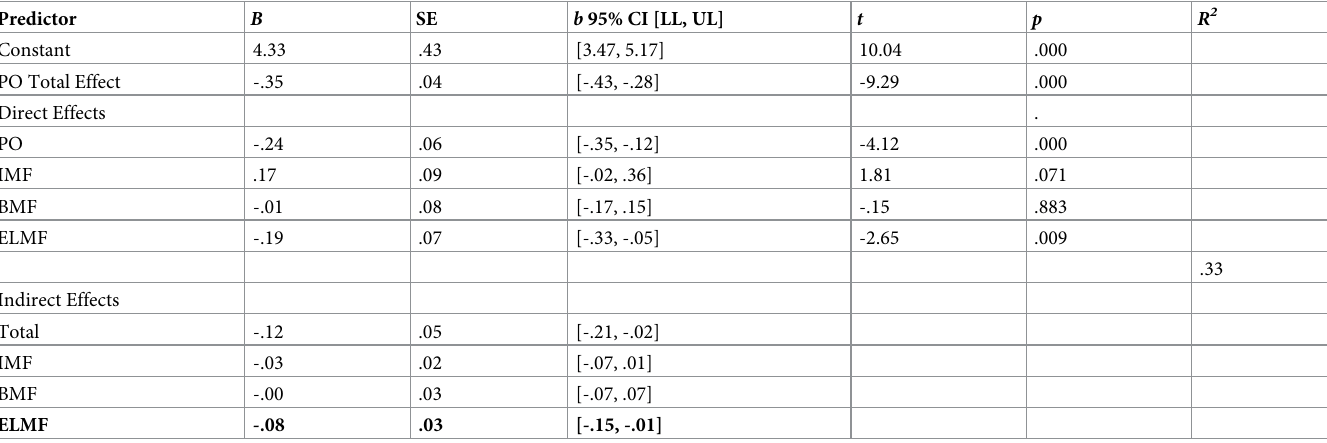
Table 13. Mediation effects of moral foundations on the relationship between political orientation and moralization scale (N = 209). Predictor Constant